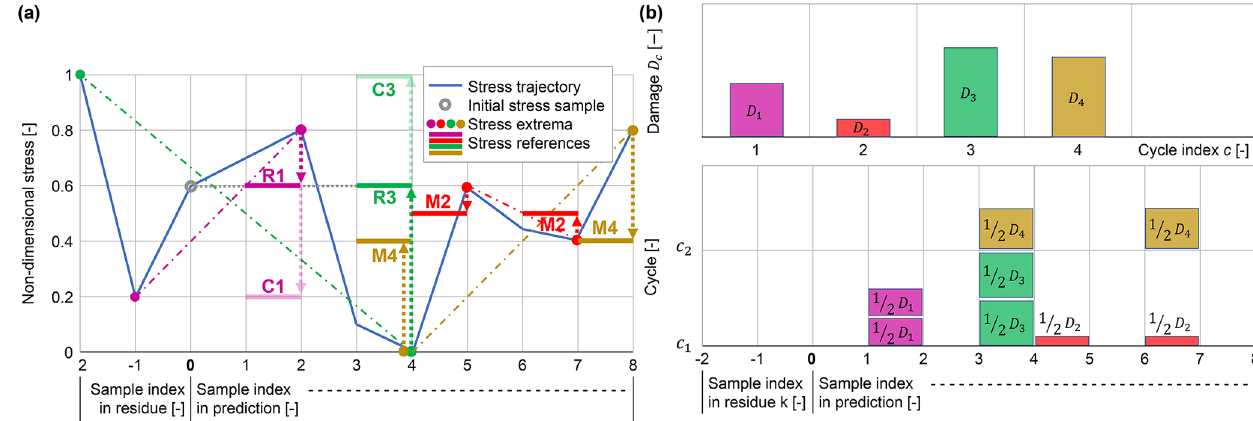
Figure 4. Stress trajectory (blue), its initial value at t 0 (grey circle), its extrema (colored dots), sequence of samples that form a cycle (dash- dotted), generated time-varying reference stresses (solid purple, red, green, yellow), and optimization goals (dotted arrows) for PORFC (a) . Corresponding distribution of damage over the prediction horizon (b) . Both figures are modified from Anand